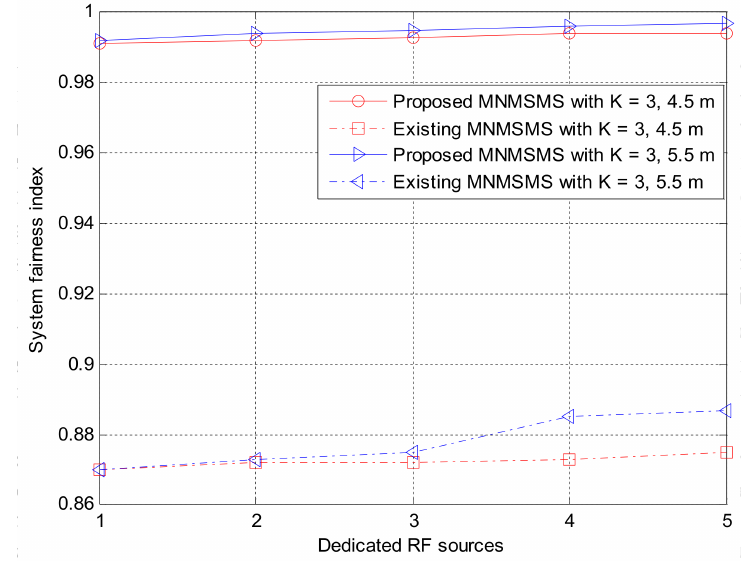
Figure 9. The impact of different network distance D UL on the system fairness